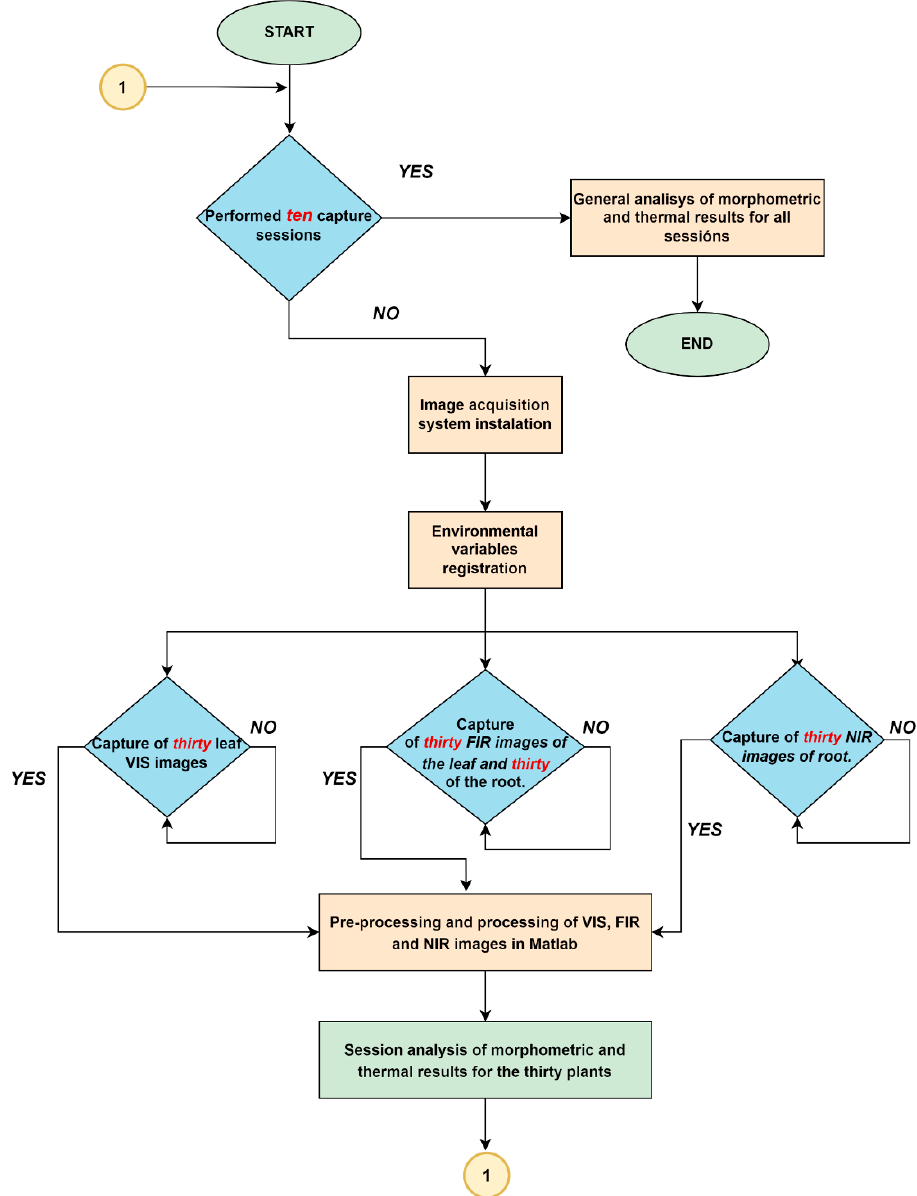
Figure 3. Proposed methodology flowchart.